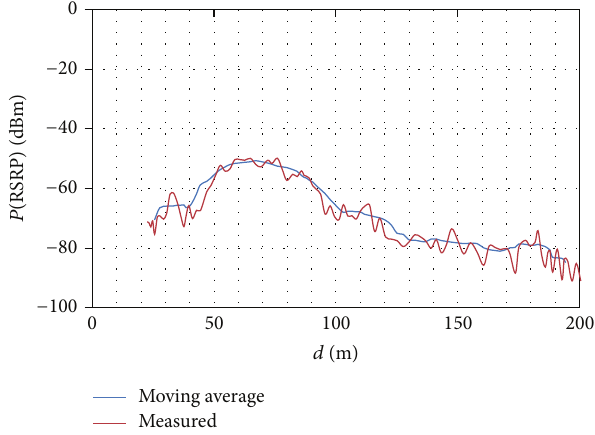
Figure 8: Reference signal received power (RSRP) of a 20MHz LTE signal for antenna tilt of 10 ∘ .